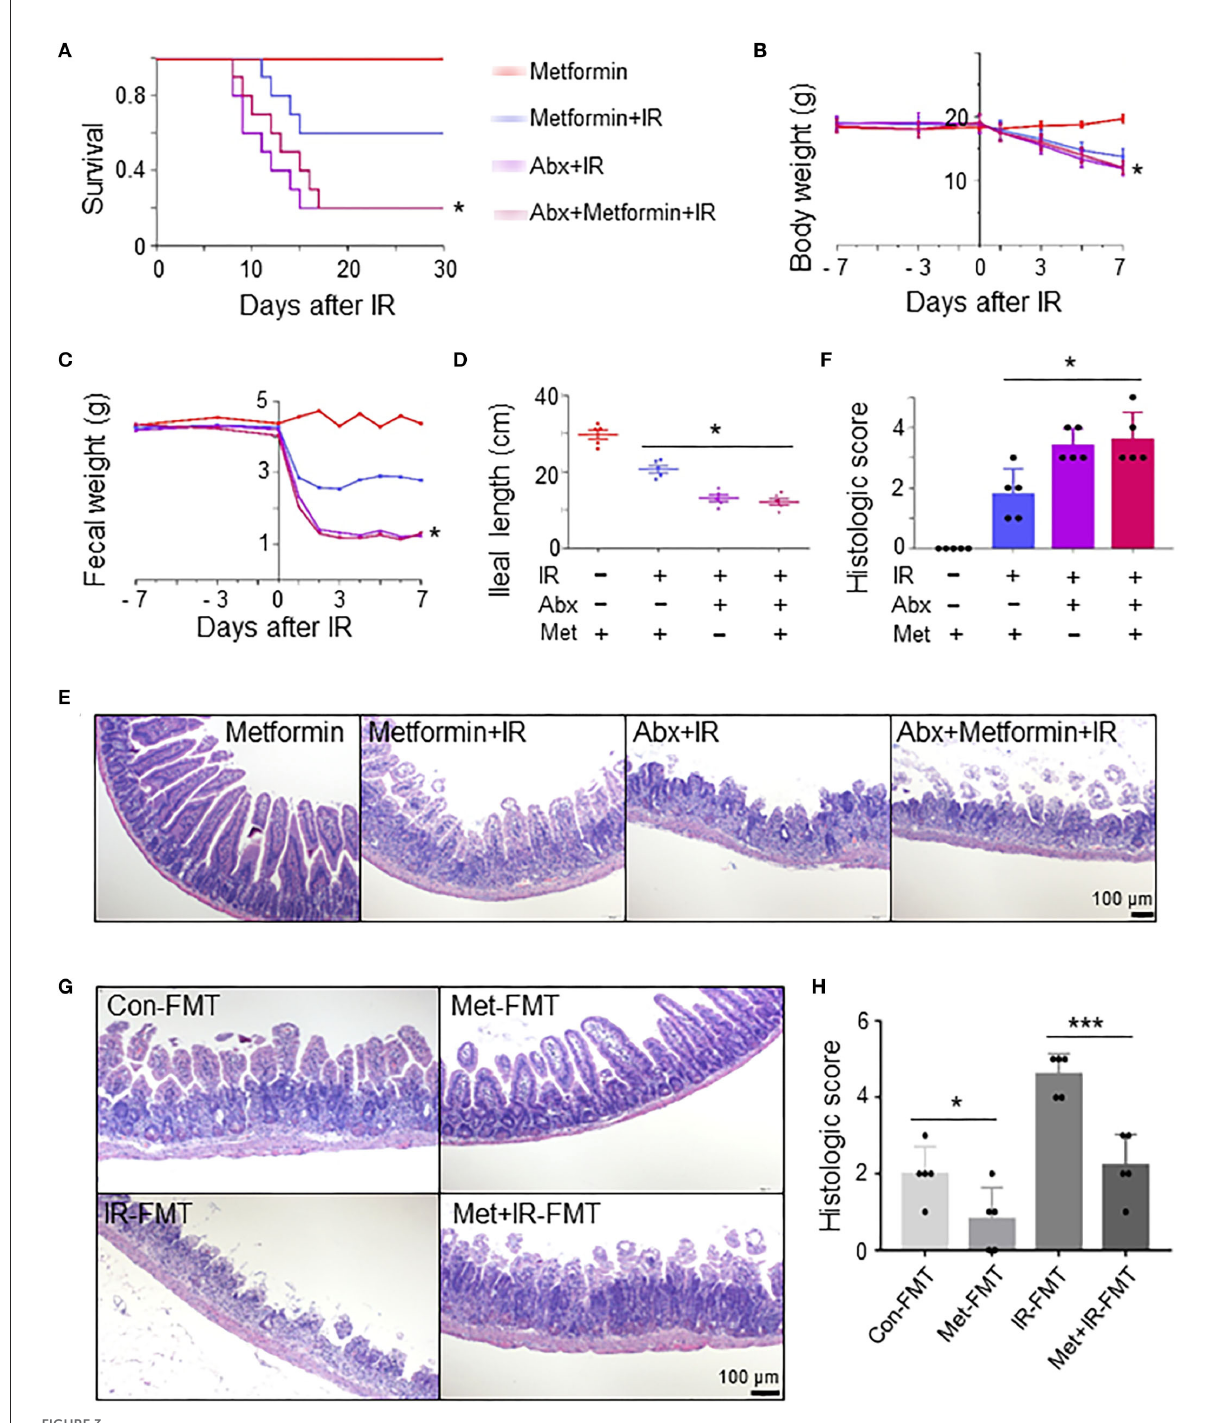
FIGURE3 Metformin reduces IR-induced intestinal damage in mice by improving the composition and abundance of microbiota. Mice were pretreated with an antibiotic mixture for 4 weeks before metformin treatment. Mice were irradiated as described in Figure 1. Ilea were collected for light microscopy 3 days after IR. The mice were monitored for (A) survival, (B) body weight, (C) fecal output, (D) ileal length, (E) H&E staining of ileum, and (F) damage score of ileal tissue. * P < 0.05, Abx + metformin + IR vs. metformin + IR. (G,H) A total of 200 µ l FMT using feces from control-, metformin-, IR-, or metformin + IR-treated mice were intragastrically administered into microbiota-eliminated mice (Abx) for 4 weeks continuously before and 1 week after IR to reorganize the intestinal microenvironment. (G) H&E staining of ileal tissues from IR mice received FMT with feces from control (Con-FMT), metformin-treated (Met-FMT), IR mice (IR-FMT), or metformin-treated IR mice (Met + IR-FMT). (H) Damage score of ileal tissues of mice in (G) . Data represent mean ± SEM. * P < 0.05, *** P < 0.001, n =